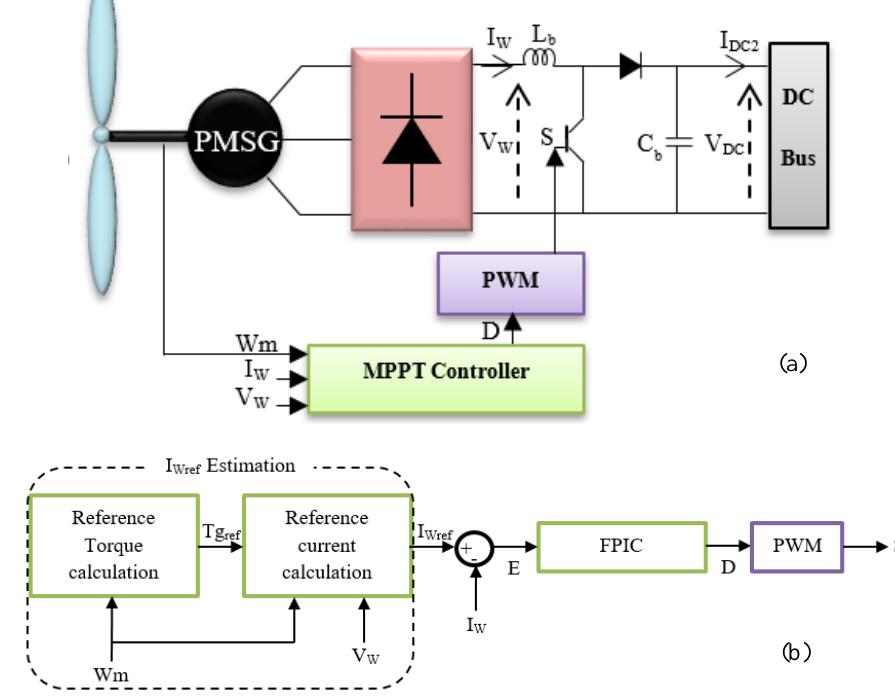
Figure 9. (a) Block diagram of the WECS; (b) Structure of MPPT controller for